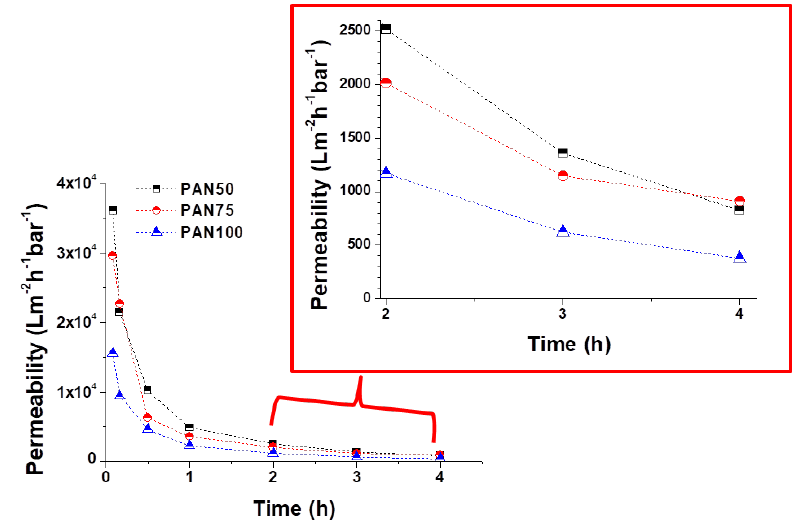
Figure 13. Permeability of PAN multilayer nanofibrous membranes at various laminating pressures over time.